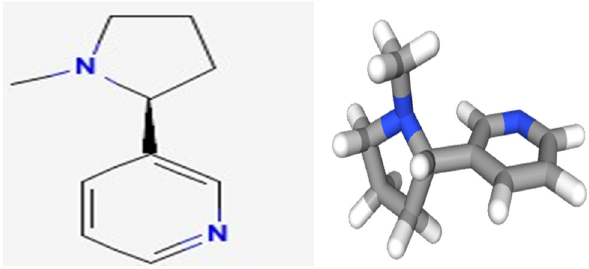
Figure 1: Shows the 2D and 3D structures of Nicotine.